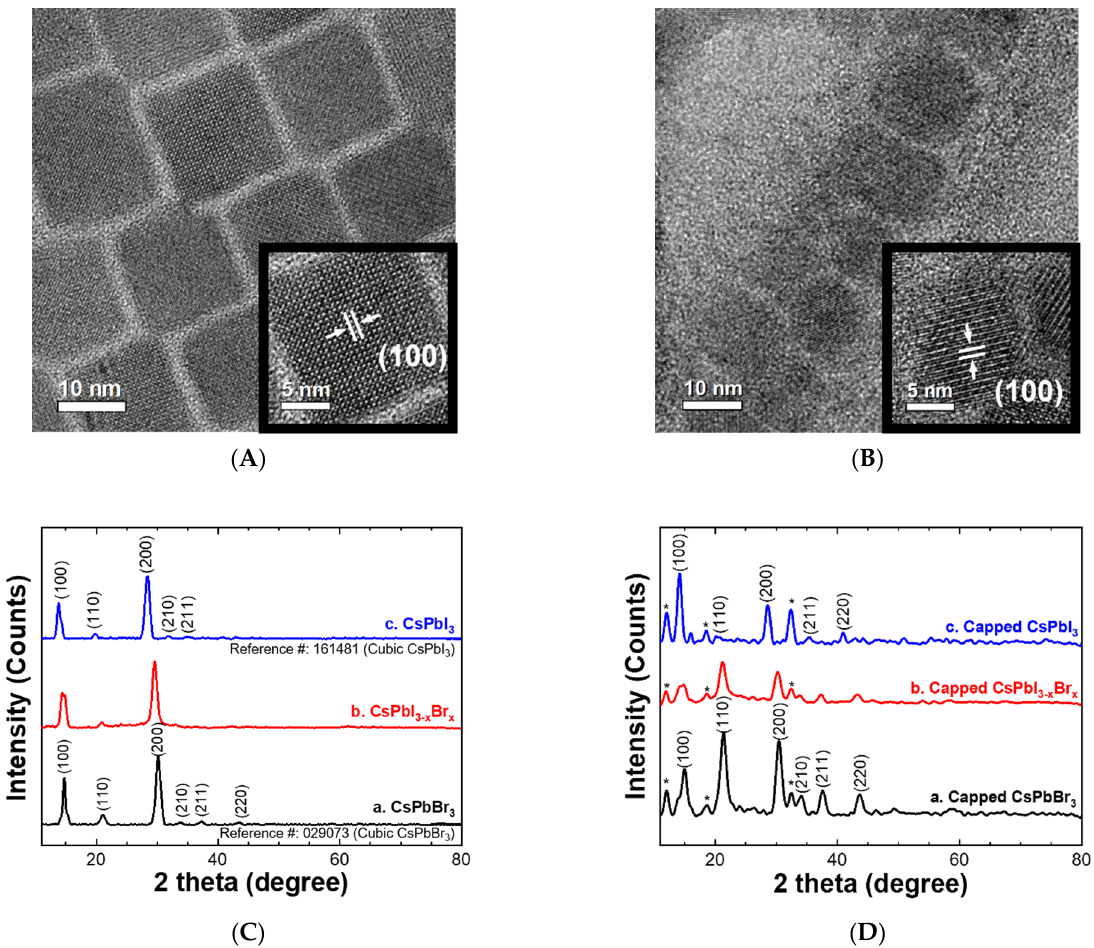
Figure 2. ( A , B ) TEM images of ( A ) pristine CsPbI 3 PQDs without PbSO 4 -oleate coverage and ( B ) capped CsPbI 3 PQDs with PbSO 4 -oleate coverage; coverage reaction time was 60 min (inset: enlarged CsPbI 3 PQDs with (100) lattice fringe). ( C , D ) XRD patterns of CsPbX 3 PQDs ( C ) without PbSO 4 -oleate coverage on PQDs and ( D ) with